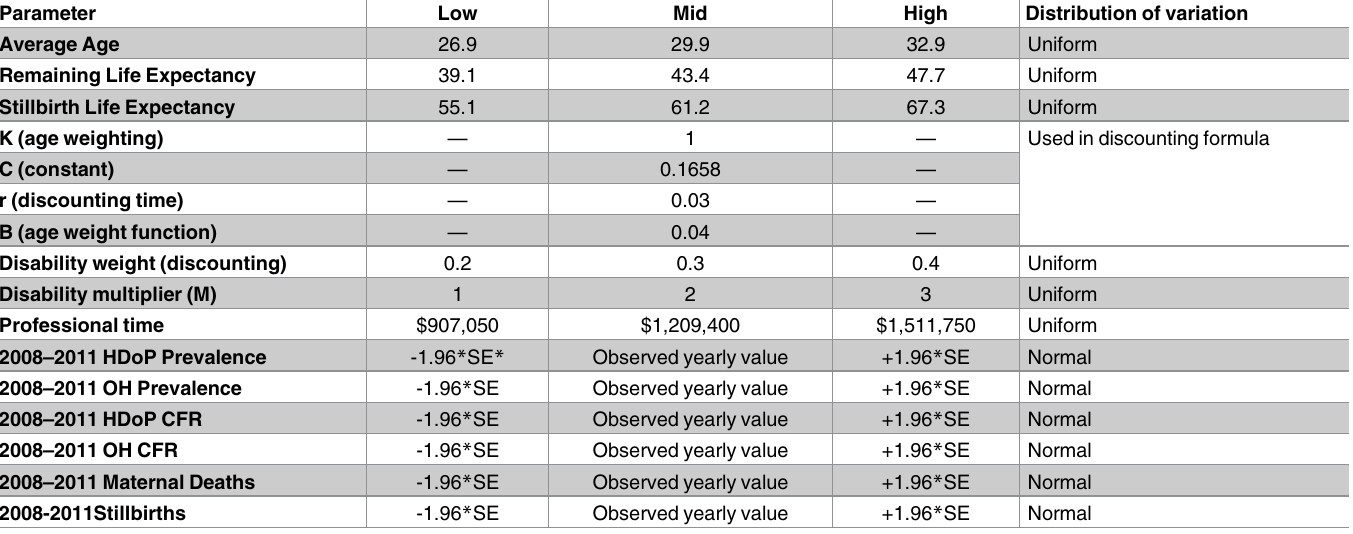
Table 2. Sensitivity analysis